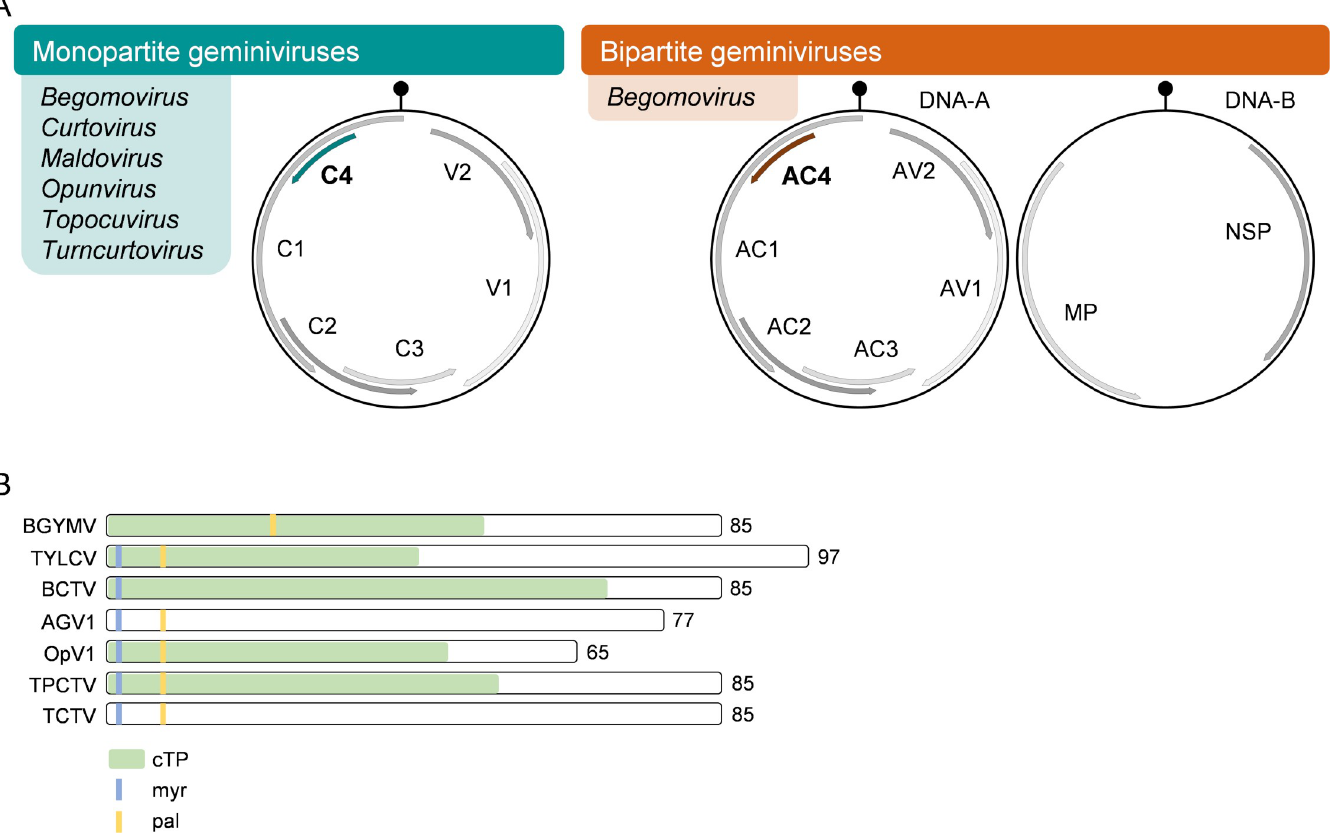
Fig 1. General features of the C4/AC4 protein encoded by geminiviruses. (A) Genome organization of geminiviruses. (B) Features of selected C4/AC4 proteins. Protein size in aa is indicated on the right. The cTP was predicted by ChloroP (http://www.cbs.dtu.dk/services/ChloroP/) [72]. The N-terminal myr site and the pal site were predicted by GPS-Lipid (http://lipid.biocuckoo.org/webserver.php) [73]. For further information, see S1 and S2 Tables. cTP, predicted chloroplast transit peptide; myr, predicted myristoylation site; pal, predicted palmitoylation site.